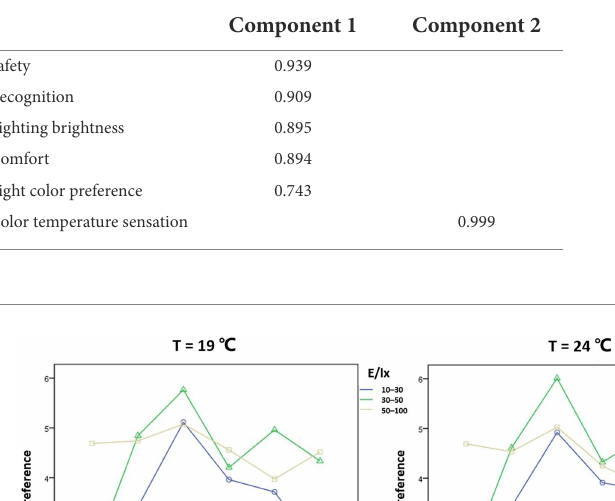
TABLE 1 Rotated component matrix.